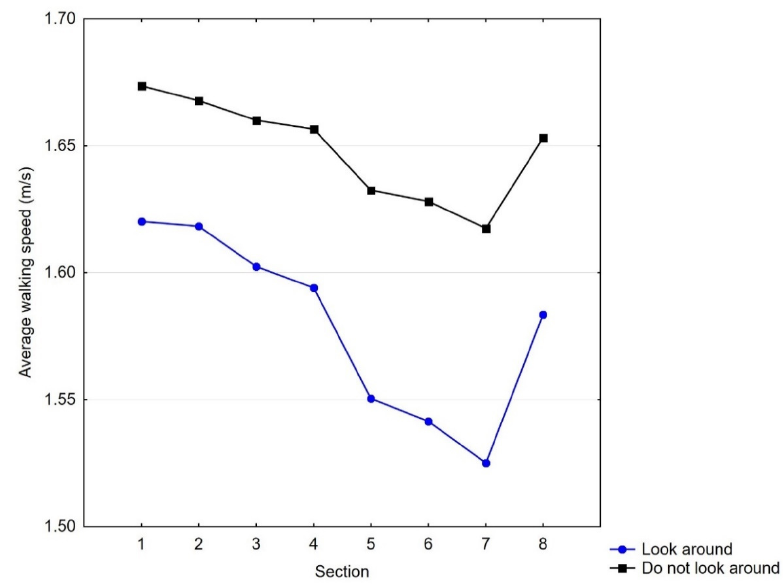
Figure 4. Average walking speeds (m/s) in specific sections of the route in Study 3.